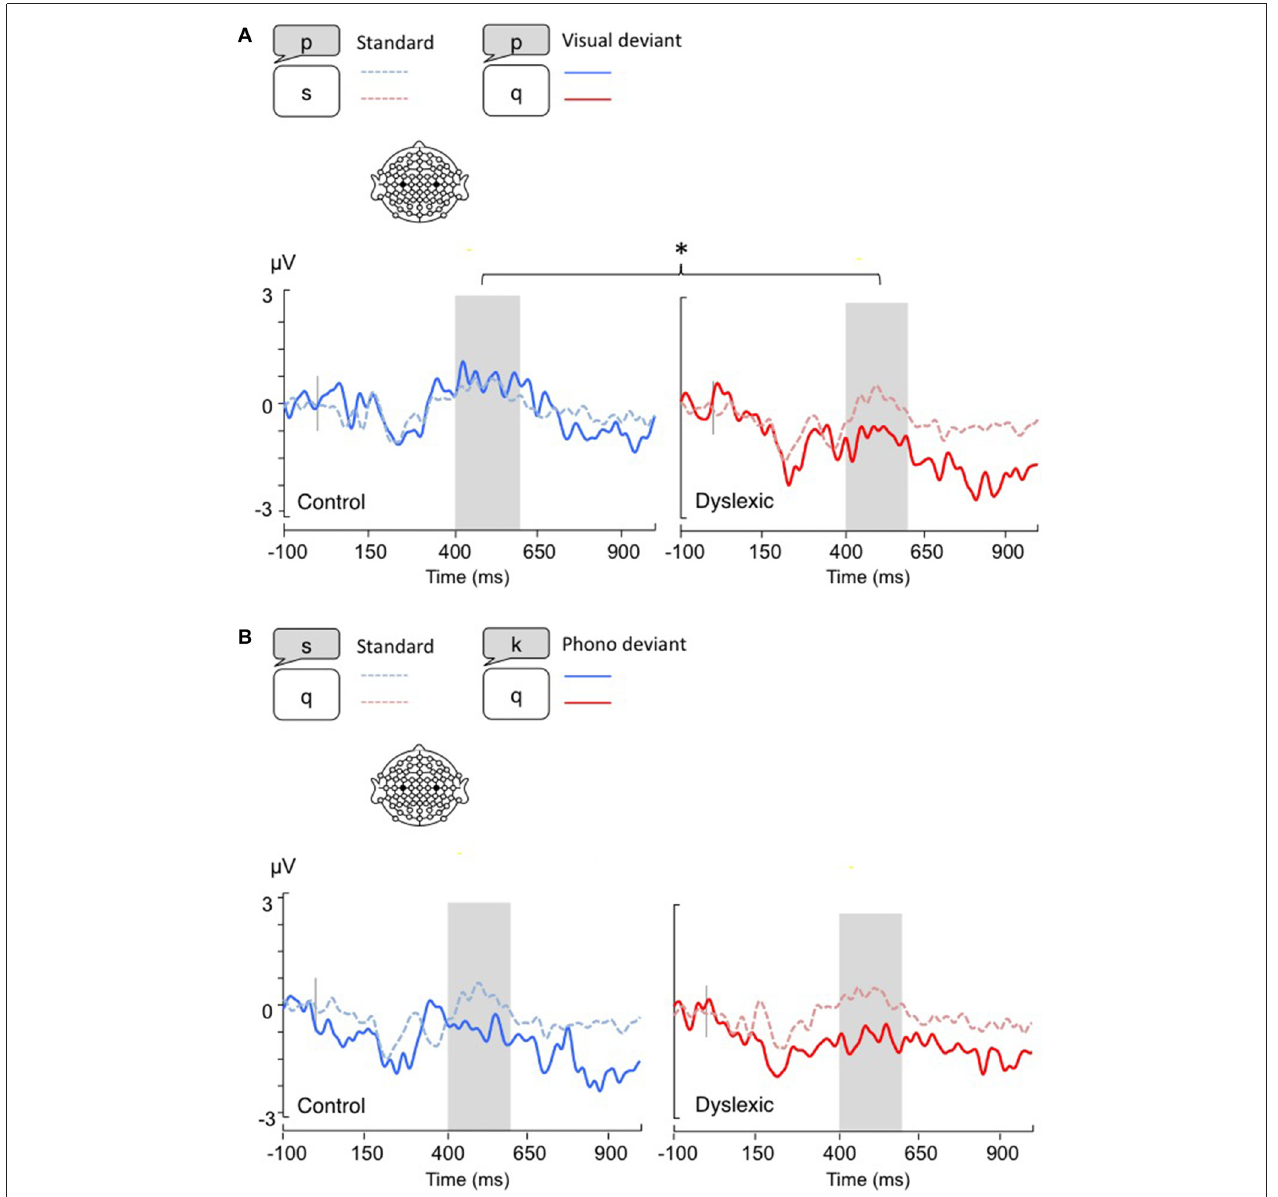
FIGURE 3 | Lateralized readiness potentials (LRPs), calculated by subtracting C4 amplitudes from C3. Gray bar: analysis window. (A) Visual-orthographic deviants; (B) Phonological deviants. * p < 0.05.